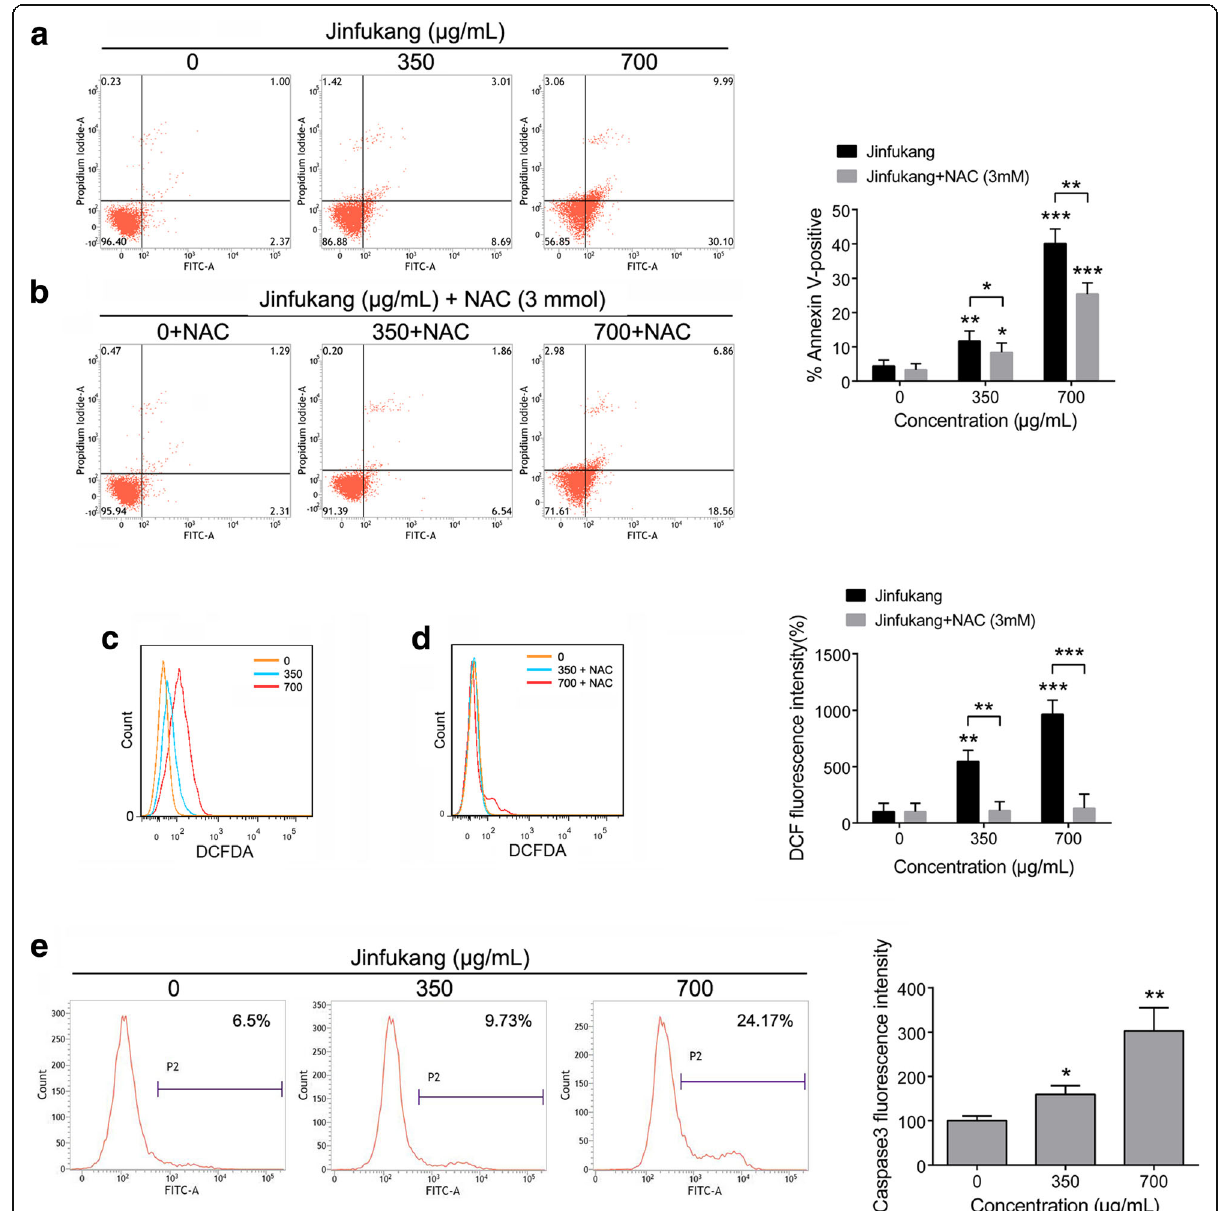
Fig. 2 Jinfukang-induced apoptosis in CTC-TJH-01 cells. a and b CTC-TJH-01 cells were treated with Jinfukang (0, 350, and 700 μ g/mL) or Jinfukang